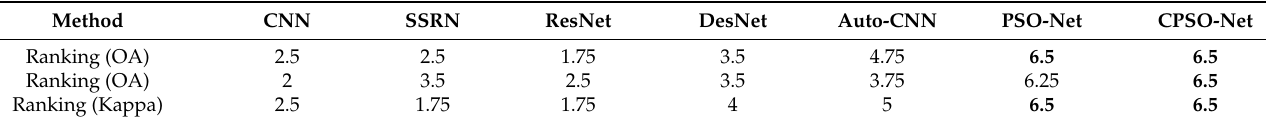
Parameters Table 7. Average rankings of Friedman test on four datasets in terms of OA, AA and Kappa, bold the best results. Method Ranking